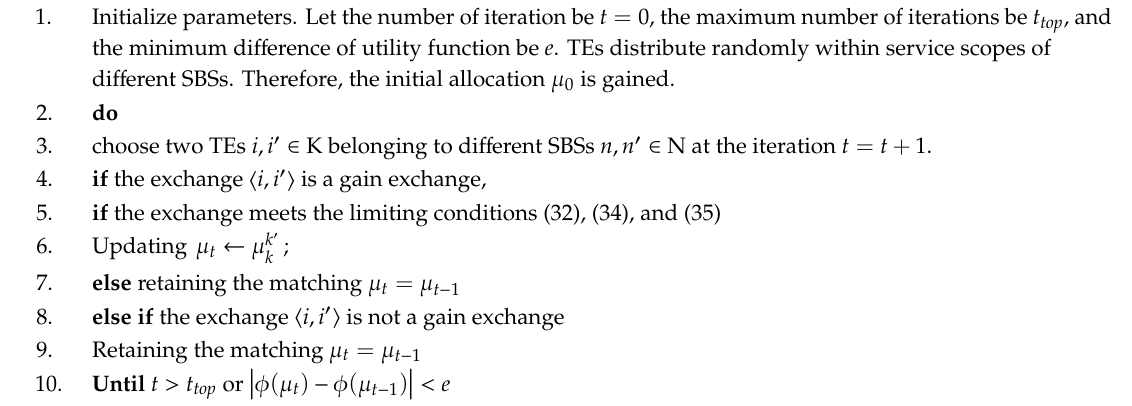
Algorithm 1: Matching game of TE